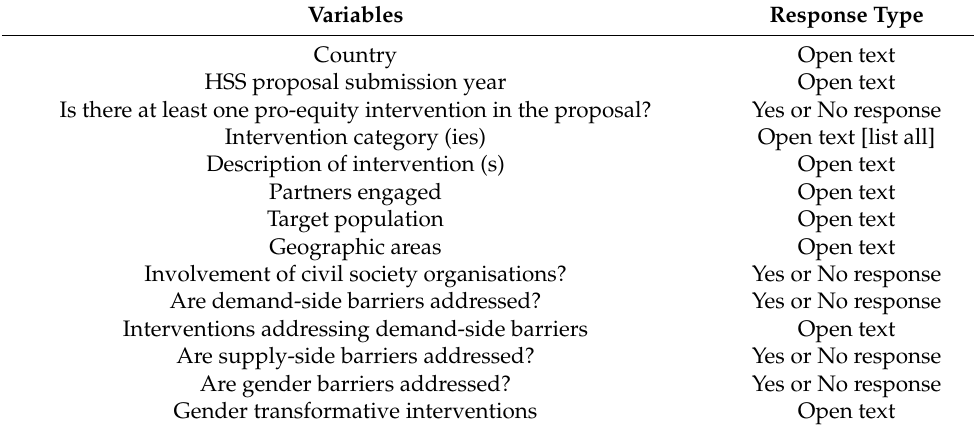
Table 1. Variables included in the analytical framework and their corresponding response